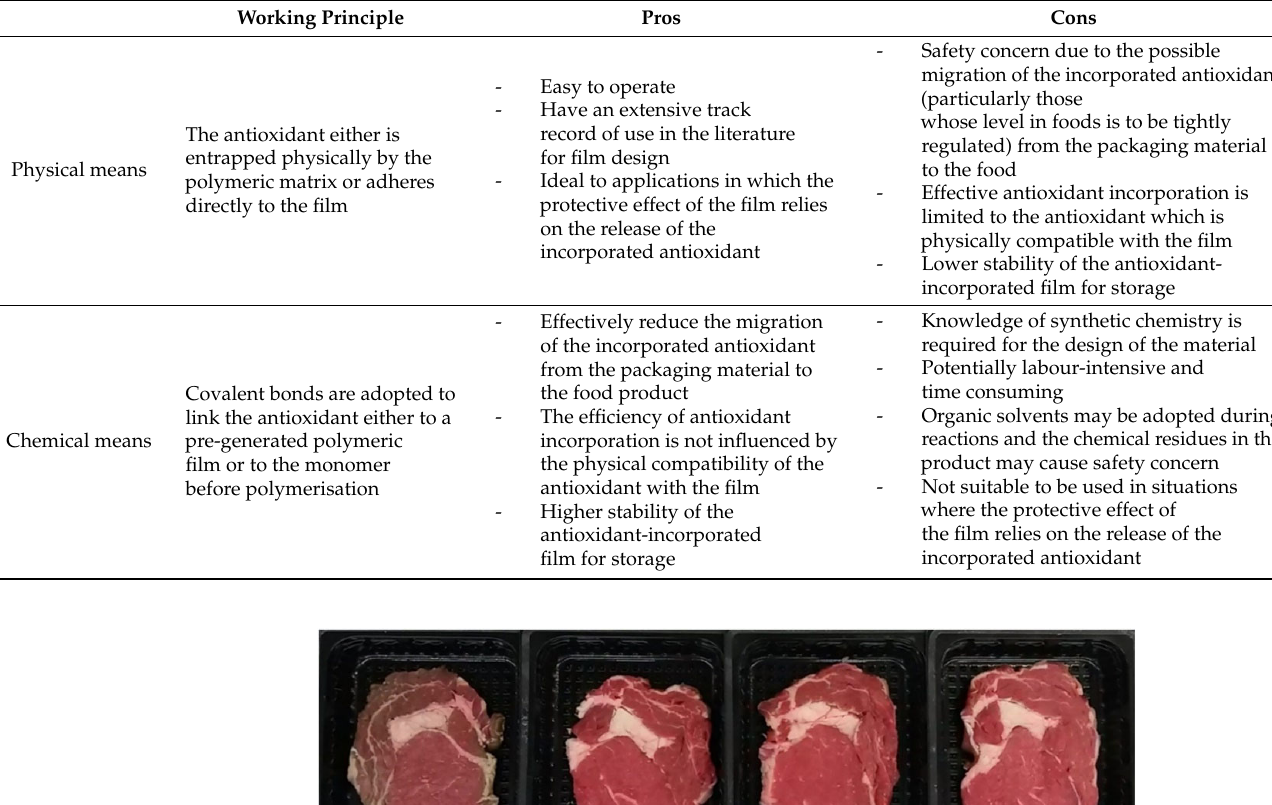
Table 1. Pros and cons of physical and chemical means of antioxidant incorporation.